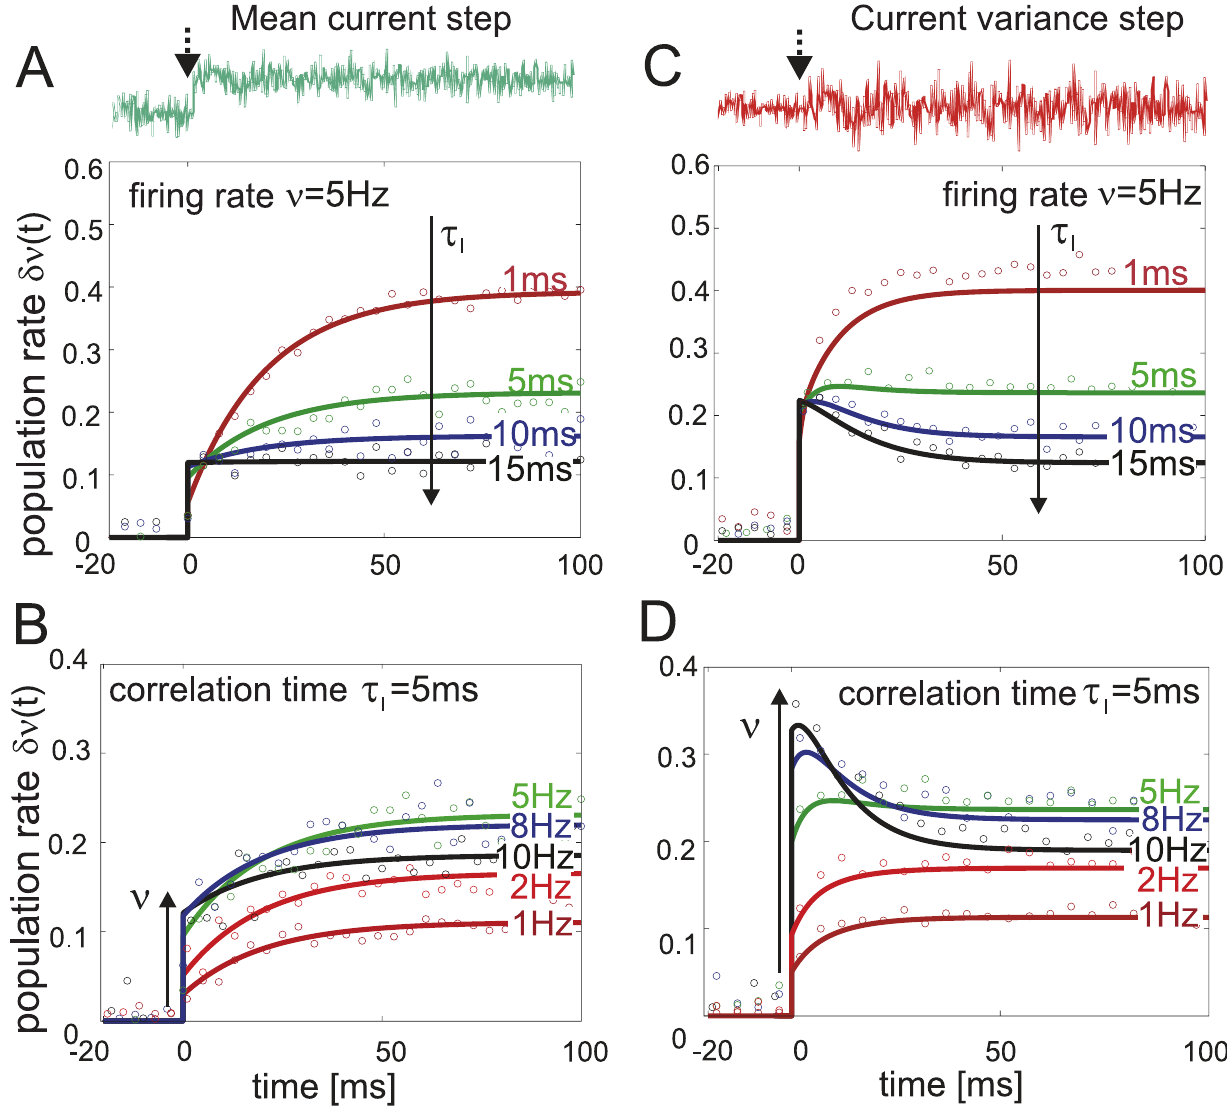
Figure 5. Firing rate response to a step-like current signal at time t ~~ 0 in a population of independent threshold neurons. (A,B) Firing rate change dn ( t ) in response to a mean current step-like increase of amplitude A , amplitude-to-threshold ratio A = y 0 ~ 0 : 02 . Analytical solution in Eq. 25 (solid lines) and simulation results (circles) are superimposed. (A) dn ( t ) for n ~ 5Hz , t M ~ 20ms and varying current correlation times t I ~ 1,5,10,15ms . (B) dn ( t ) for t I ~ 5ms( t s ~ 10ms) , t M ~ 20ms and n ~ 1,2,5,8,10Hz . (C,D) Firing rate change dn ( t ) in response to an step-like increase of the current variance s ? s (1 z ds ), ds ~ 0 : 02 . (C) n ~ 5Hz and t I ~ 1,5,10,15ms , t M ~ 20ms . (D) dn ( t ) for t I ~ 5ms( t s ~ 10ms) , t M ~ 20ms and n ~ 1,2,5,8,10 Hz . Analytical solution in Eq. 26 (solid lines) and simulation results (circles) are superimposed. Note that the evoked change of the stationary firing rate in A and C, B and D is the